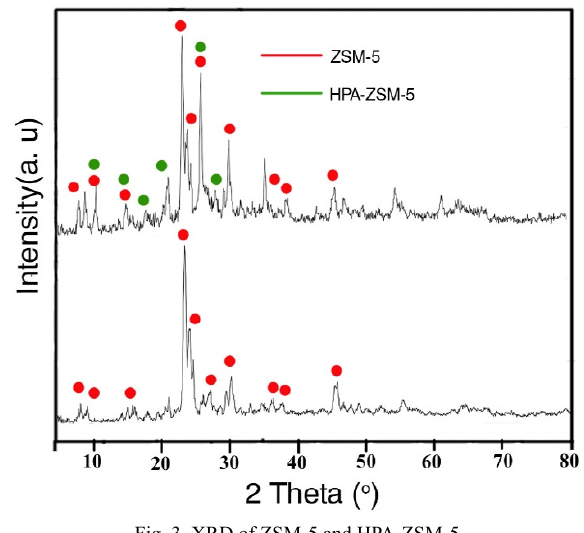
Fig. 3. XRD of ZSM-5 and HPA-ZSM-5 Figure 3 . XRD of ZSM-5 and HPA-ZSM-5